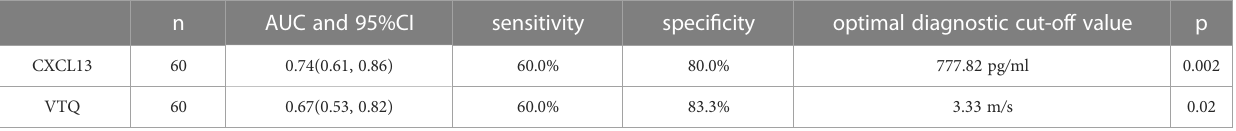
TABLE 4 Areas under the ROC curves, sensitivity, speci fi city, and optimal threshold value for both the two techniques.